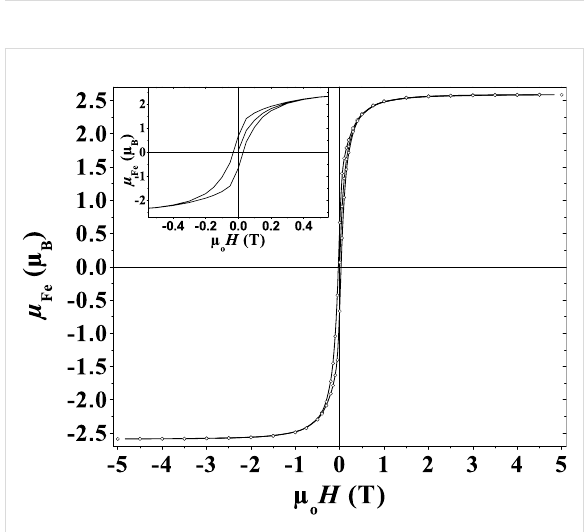
Figure 7: AC susceptibility measured for various frequencies (symbols) and their fits (solid lines).